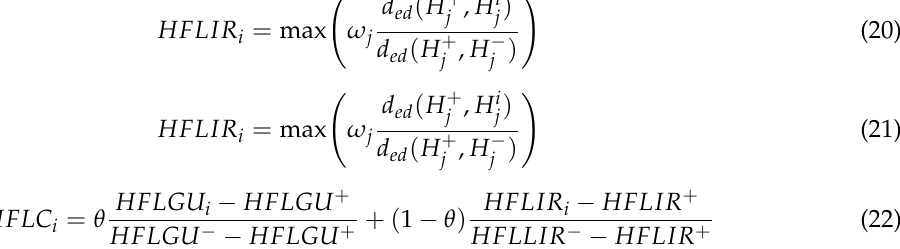
Table 3. The decision-making results obtained by the HFL-VIKOR method.